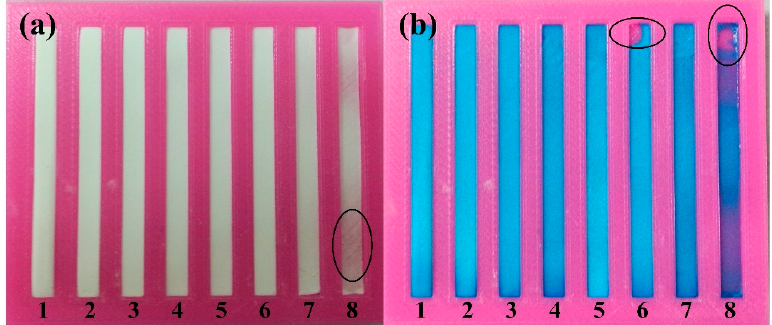
Figure 3. Cellulose powder channels fabricated with different proportion: ( a ) Comparison between the fabricated channels; ( b ) Blue dye was dropped to test the channels’ quality.